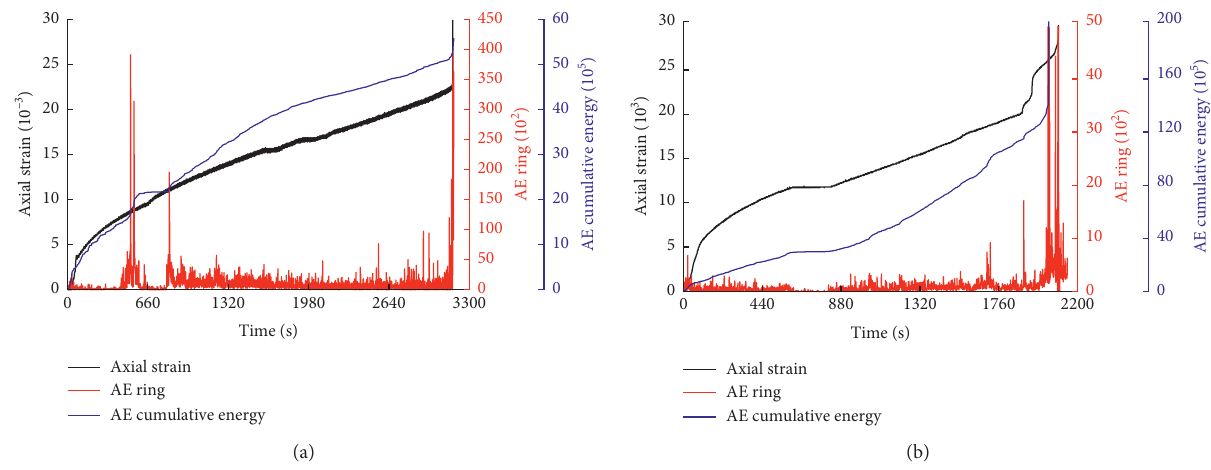
Figure 14: Evolution of stress, strain, count of AE events, and energy of samples. (a) marble and (b)